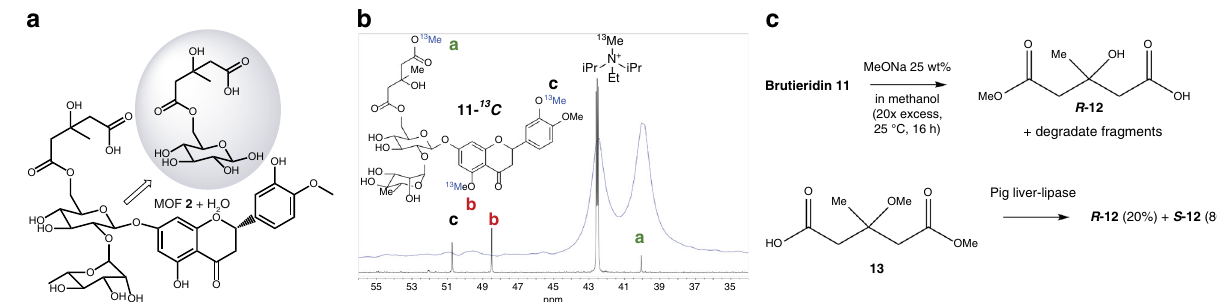
Fig. 3 Hydrolysis of brutieridin 11. a Chemical structure of brutieridin 11 . Gray-colored ellipse highlights the fragment 11a , which contains the chiral carbon and encapsulates within the MOF after the break of the glycosidic bonds. b Chemical structure and 13 C NMR spectrum of 11- 13 C in solution (black line), and MAS solid 13 C NMR spectrum of MOF 2 after hydrolysis of 11- 13 C (blue line). The isotopically labeled carbon atoms are lettered ( a – c ). c Hydrolisis of 11 with sodium methoxide to give chiral fragment 12 , and synthesis of 12 by enzymatic hydrolysis of diester 13 .